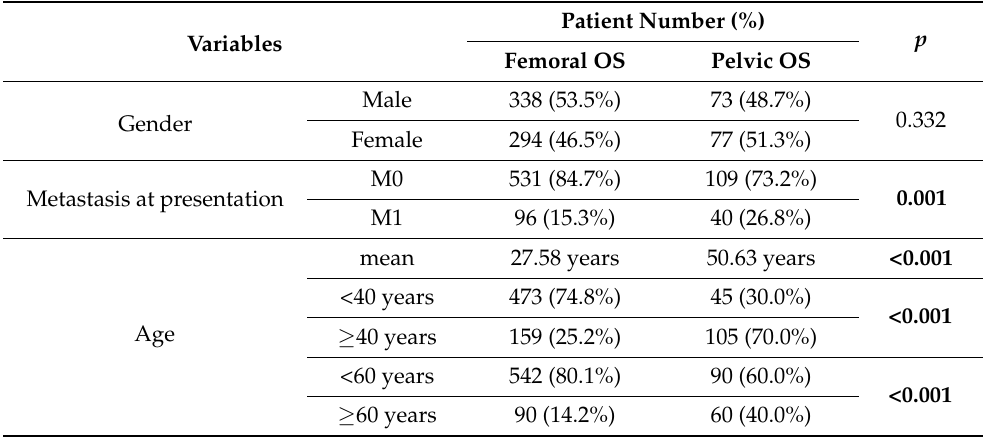
Table 1. Clinical characteristics of the patients with femoral and pelvic